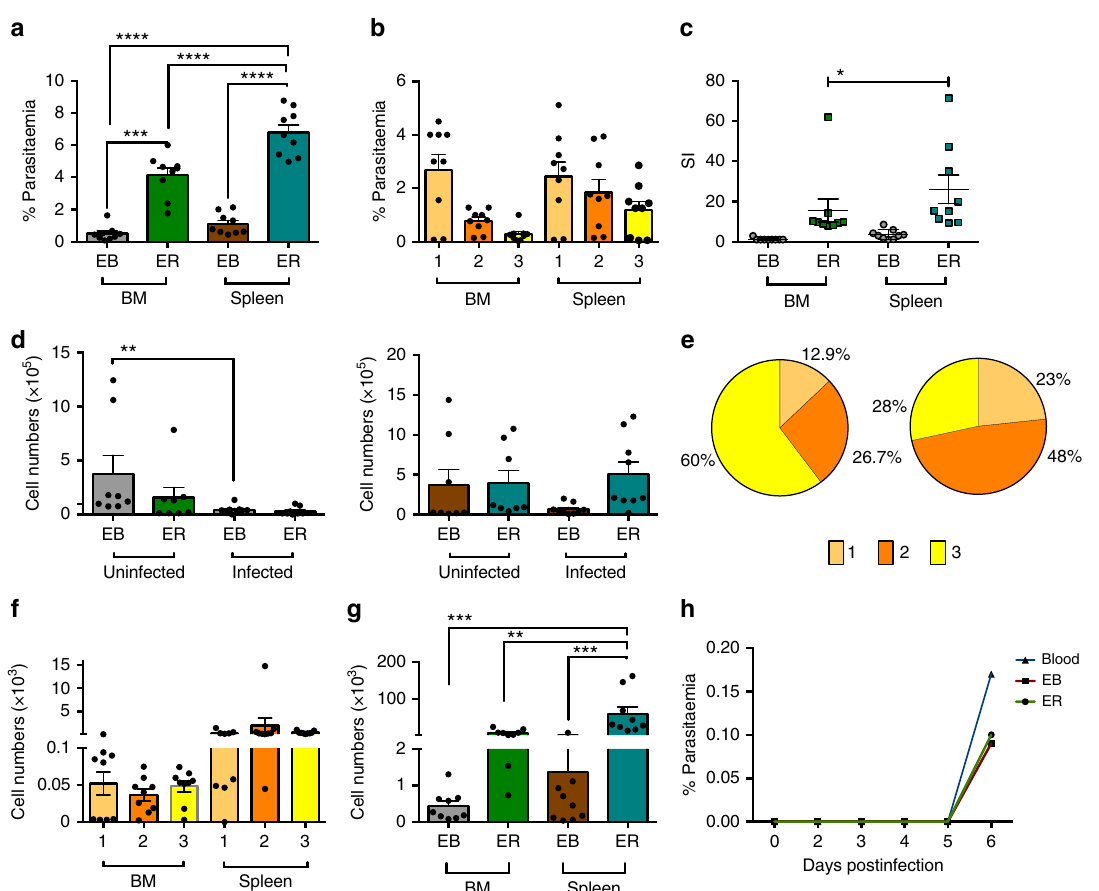
Fig. 2 P. berghei preferentially invades early reticulocytes (ER) within bone marrow (BM) and particularly spleen. a P. berghei demonstrates a preference for infection of ER compared with erythroblasts (EB) in the BM and spleen of BALB/c mice at day 7 pi. Error bars ± SEM of individual values from the different experiments shown as points. b P. berghei does not show a preference for particular EB stages (1 – 3 as de fi ned in Fig. 1) within BM and spleen of BALB/c mice as judged by percentage of invaded cell, under the assumption that the rate of random invasion is constant. Error bars ± SEM as in a . c The relative selectivity index for tissue resident erythroid cells was calculated for each animal by normalising the percentage parasitemia as a fraction relative to the smallest parasitemia. Error bars ± SEM as in a . d Numbers of total EB, though not ER are reduced in BM and spleen of infected BALB/c mice. Error bars ± SEM as in a . e Pie charts show the average proportion of each erythroblast stage in uninfected spleen (left) and infected spleen (right) of BALB/c mice. f P. berghei shows no preference for infection of erythroblast stages in the BM and spleen of BALB/c mice. Error bars ± SEM as in a . g P. berghei shows a strong preference for ER vs EB compartments in spleen and BM of BALB/c mice. Infected samples n = 9; uninfected n = 9. Error bars ± SEM as in a . h 100 GFP + ER and EB cells were FACS sorted from spleen along with 100 GFP + erythroid cells from the peripheral blood. n = 1. These were introduced into naive animals and the subsequent infections monitored by blood smears. Data from three independent experimental replications. Signi fi cant difference between groups or samples was tested using a one-way ANOVA alongside Dunnett ’ s multiple comparisons test, except for fi gure e , which was measured using a pair t- test. Signi fi cance is indicated with asterisks, denoting as follows: * p < 0.05, ** p < 0.01, *** p < 0.001, **** p <